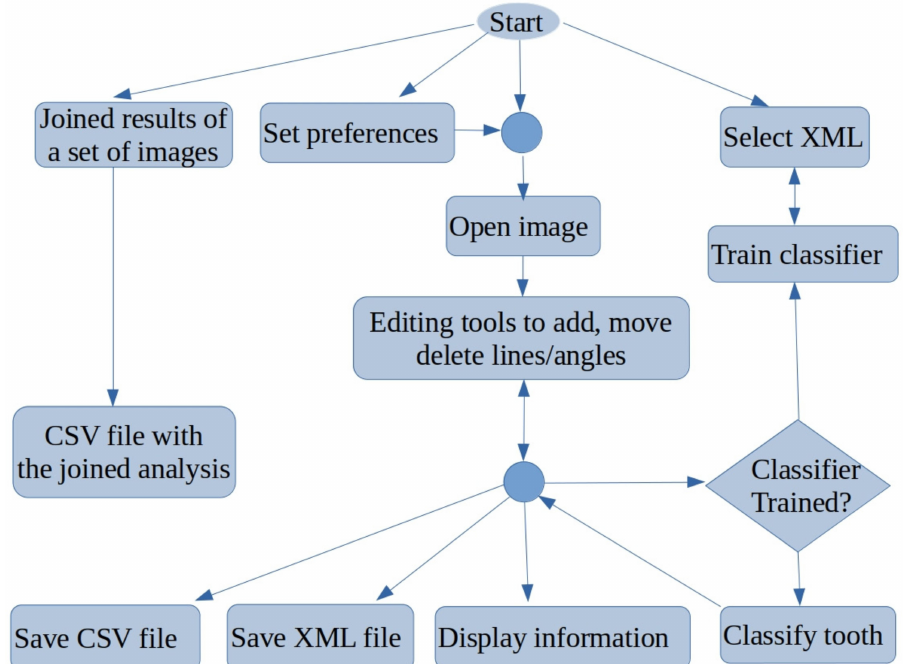
Figure 2. Flowchart of main functionality of